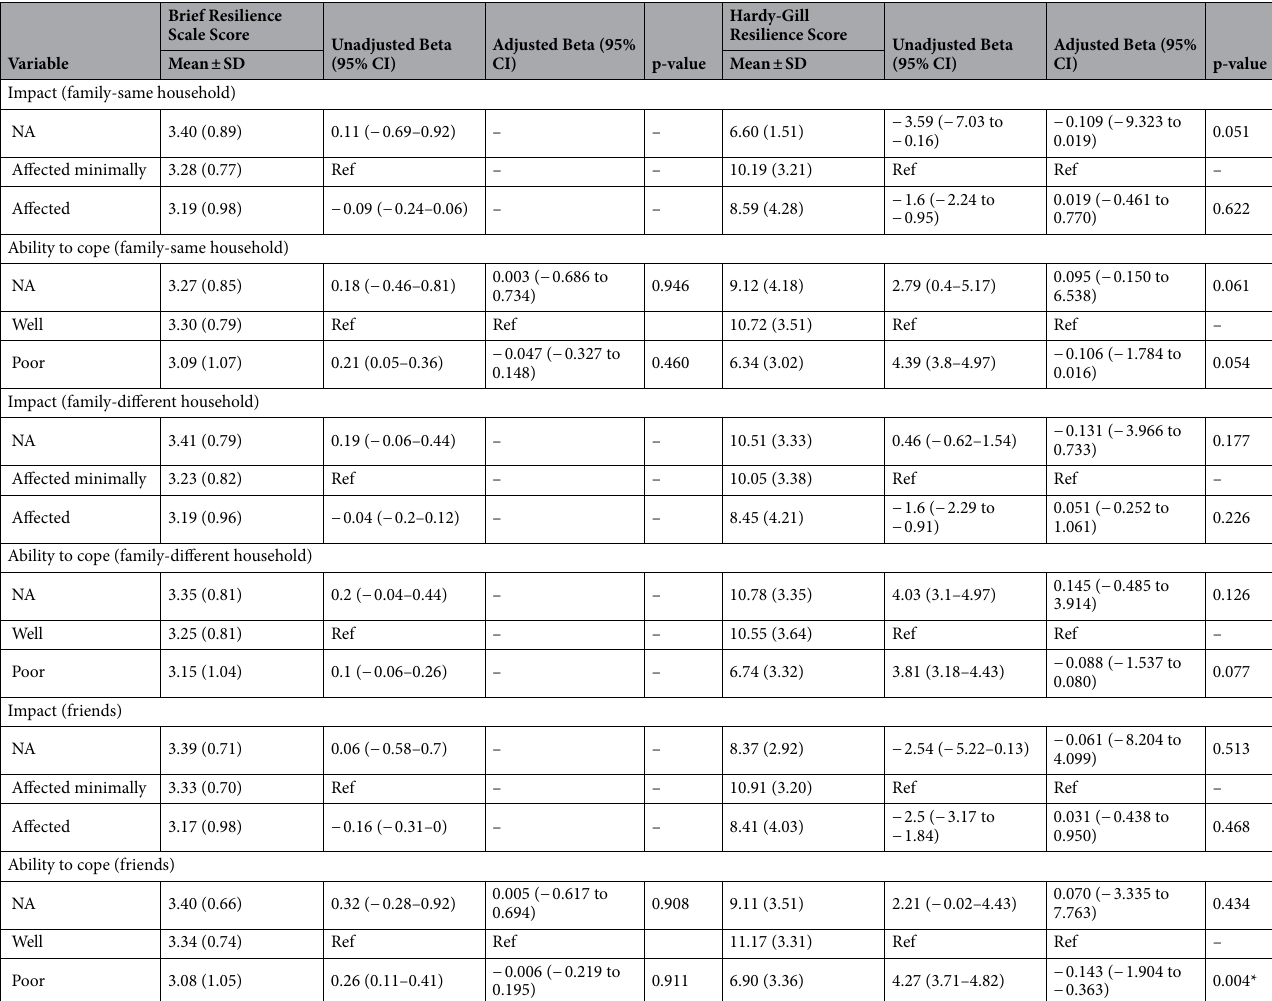
Table 5. Association between social interaction and resilience score. *p < 0.05. Model for BRS is adjusted for ethnicity and housing type. Model for HGRS is adjusted for gender, nationality, ethnicity and education